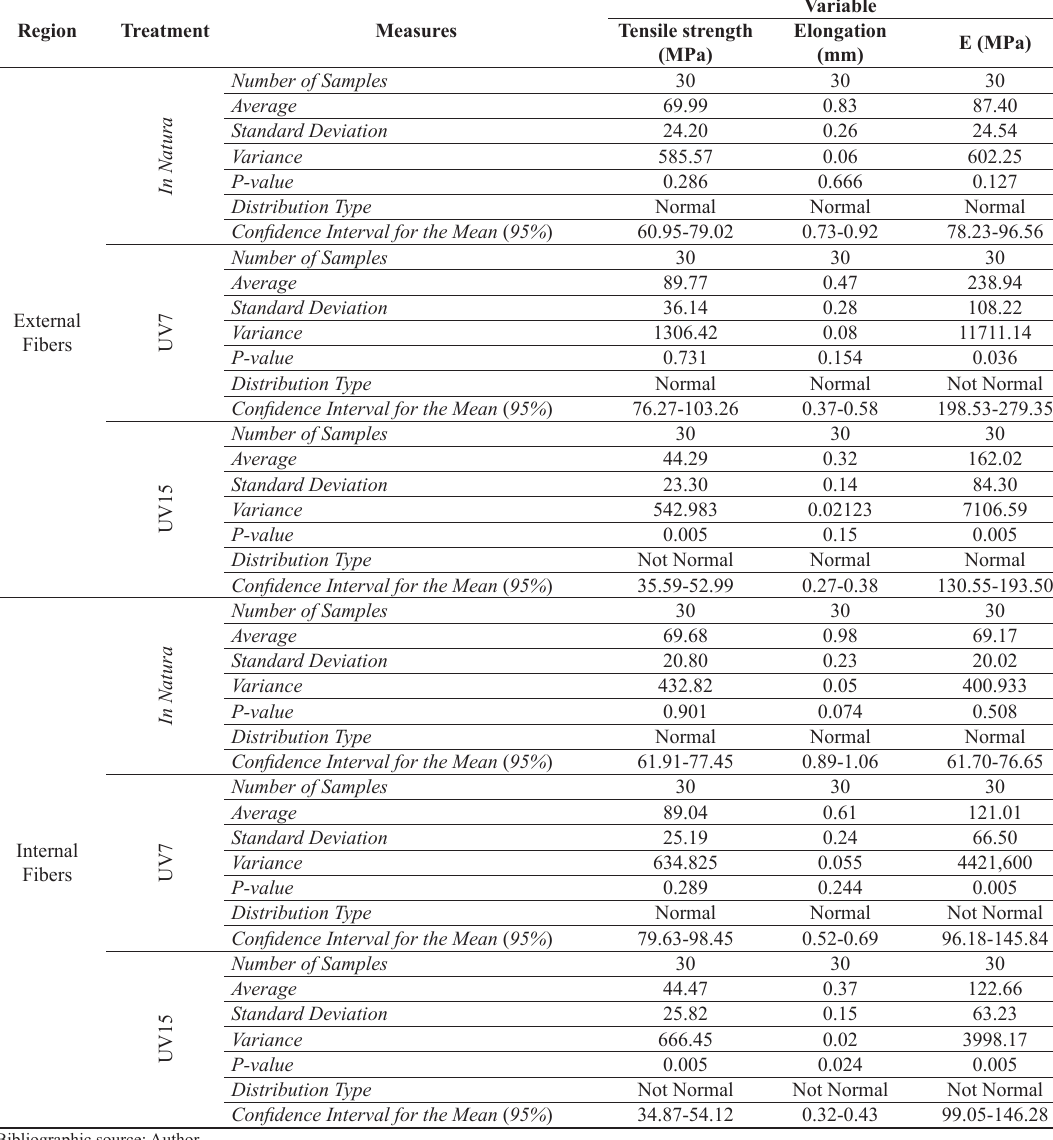
Table 1. Basic statistics of the data distribution of tensile strength, deformation and E of the BFs.